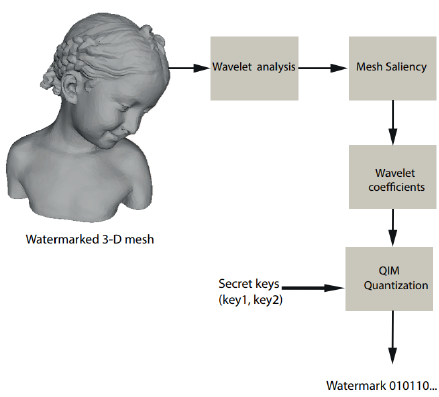
Figure 5. The proposed extraction